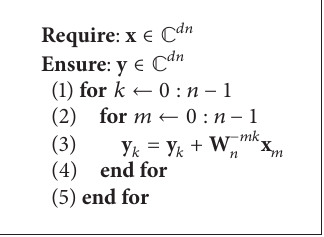
Algorithm 1: Vector-valued DFT (sequential